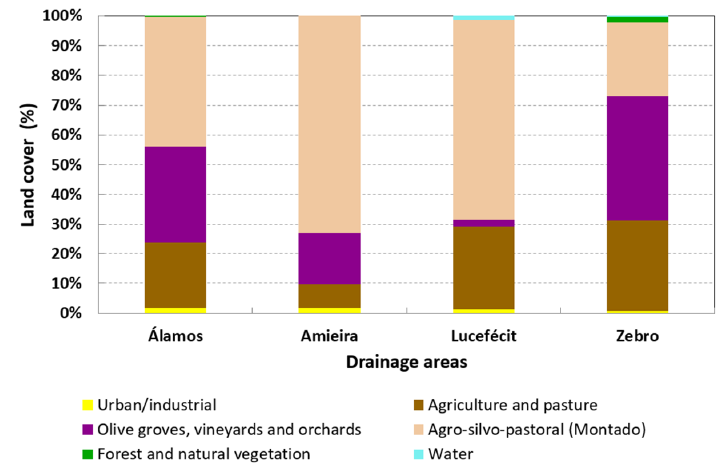
Figure 2. Percentages of the land use/land cover (LULC) classes in the selected drainage areas.